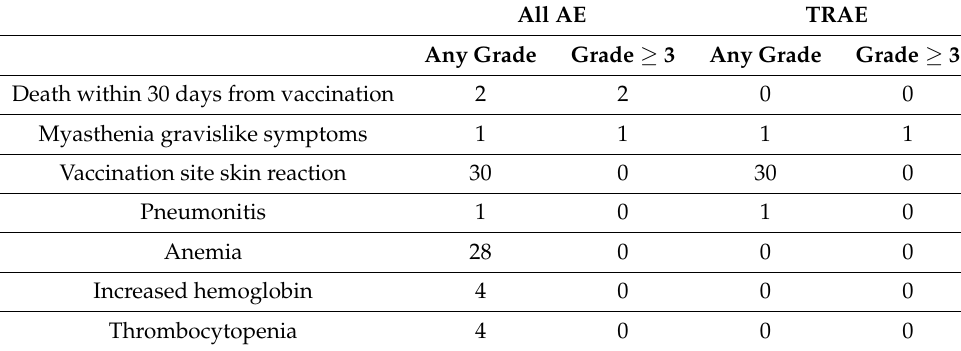
Table 2. Adverse Table 2. Adverse events.